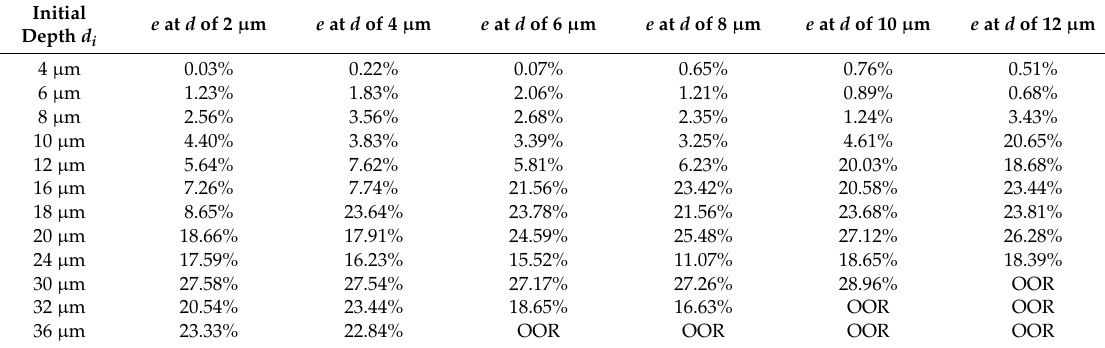
Table 1. Error of multiple depth from defocus (MDFD) at di ff erent initial depth and step